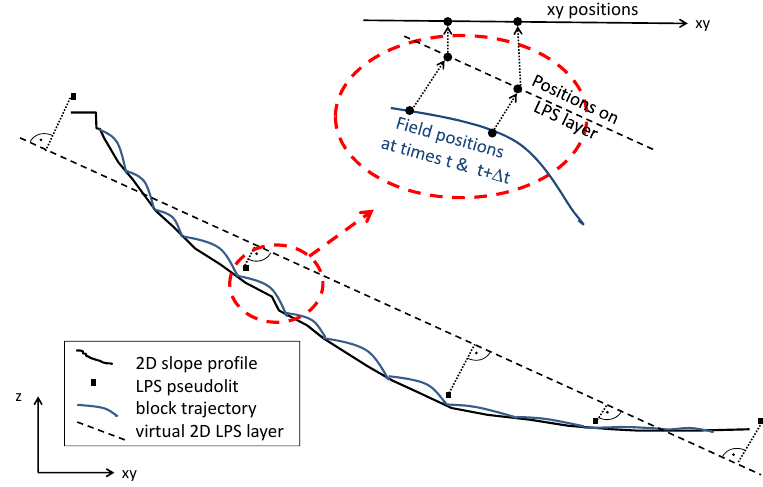
Figure 17. Calculation of the horizontally projected block position: The real position in the field is calculated relative to the internal 2D layer of the LPS; the xy position is then calculated relative to the overall coordinate